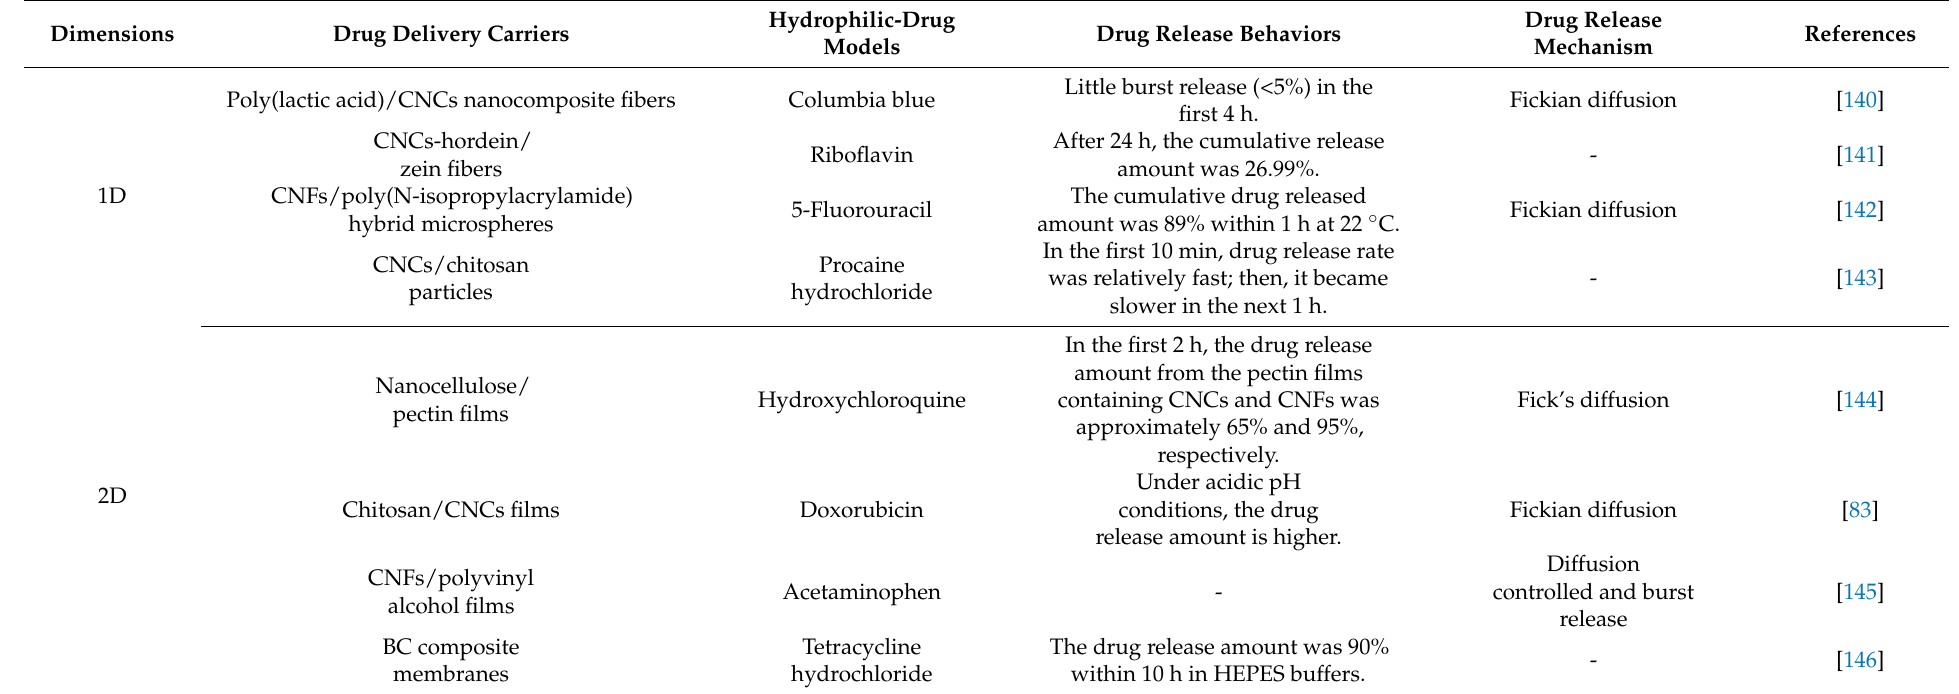
Table 2. Nanocellulose-based materials used in hydrophilic-drug delivery